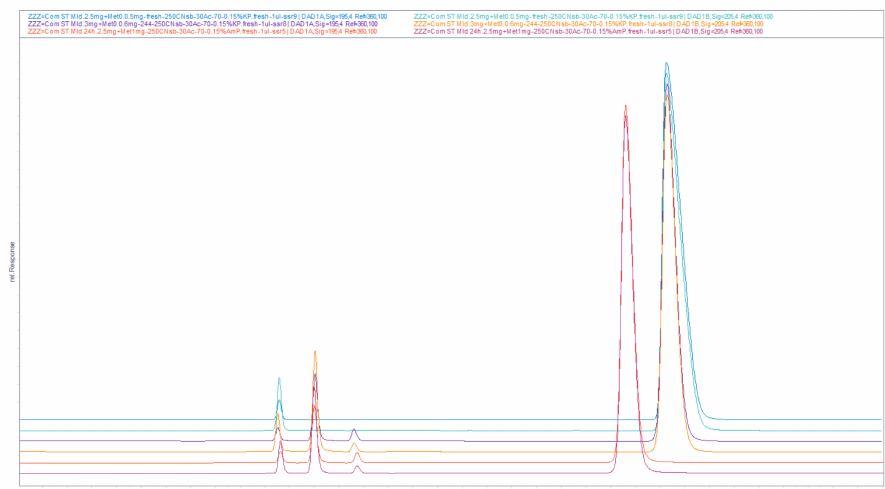
Figure 40. Chromatograms, obtained by usage of the ACN content to 30% with 70% 13 mM NH 4 H 2 PO 4 the last at bottom two chromatograms, and replaced with 13 mM KH 2 PO 4 above them. The last top chromatograms were made from a fresh sample prepared with 13 mM KH 2 PO 4 70% and 30% ACN, with noticeable width spread and small retention shift of metoprolol peak.